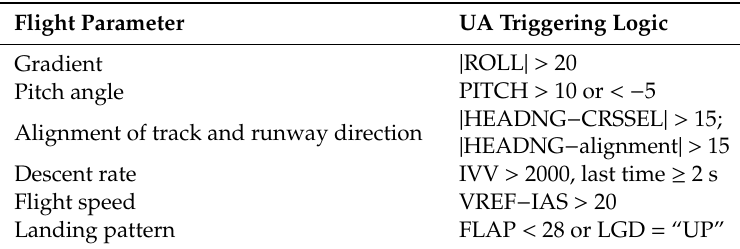
Table 2. Detection program triggering